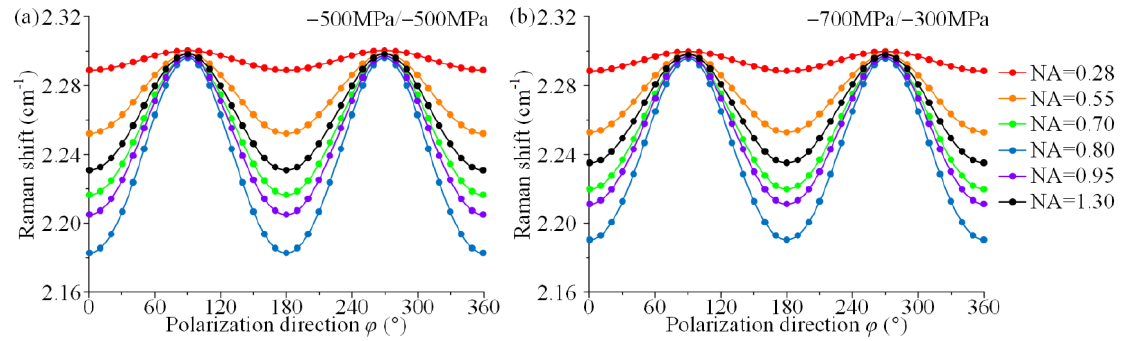
Figure 8. Simulation experiment of ( a ) biaxial ( σ 11 = σ 22 = − 500 MPa) and ( b ) unequal biaxial ( σ 11 = −700 MPa, σ 22 = −300 MPa) stress states at different NA.